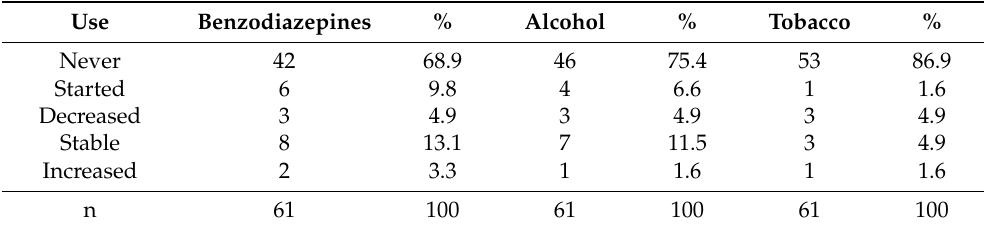
Table 10. Frequency of substance